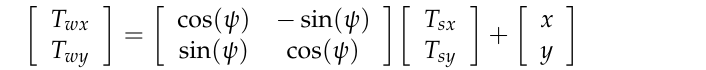
Figure 5. Features extraction of sonar data. ( a ) Raw sonar data. ( b ) Sonar data after feature extraction. The sonar data are based on the airborne coordinate system, which needs to be converted to the navigation coordinate system. The rotation and translation formula is depicted in Equation